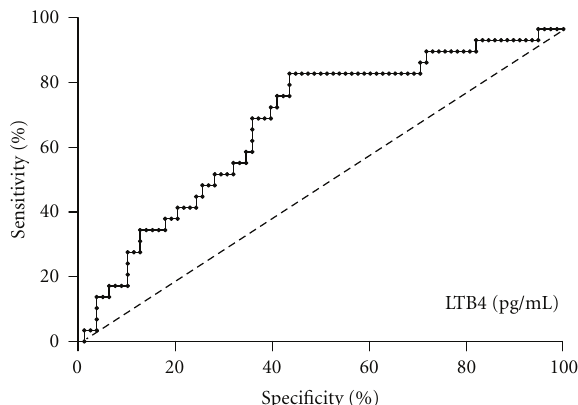
Figure 4: Receiver operating curve showing the optimal cuto ff for LTB4 levels (109.6 pg/mL in predicting the presence or absence of postinjury pulmonary complications with 72% specificity and 67%